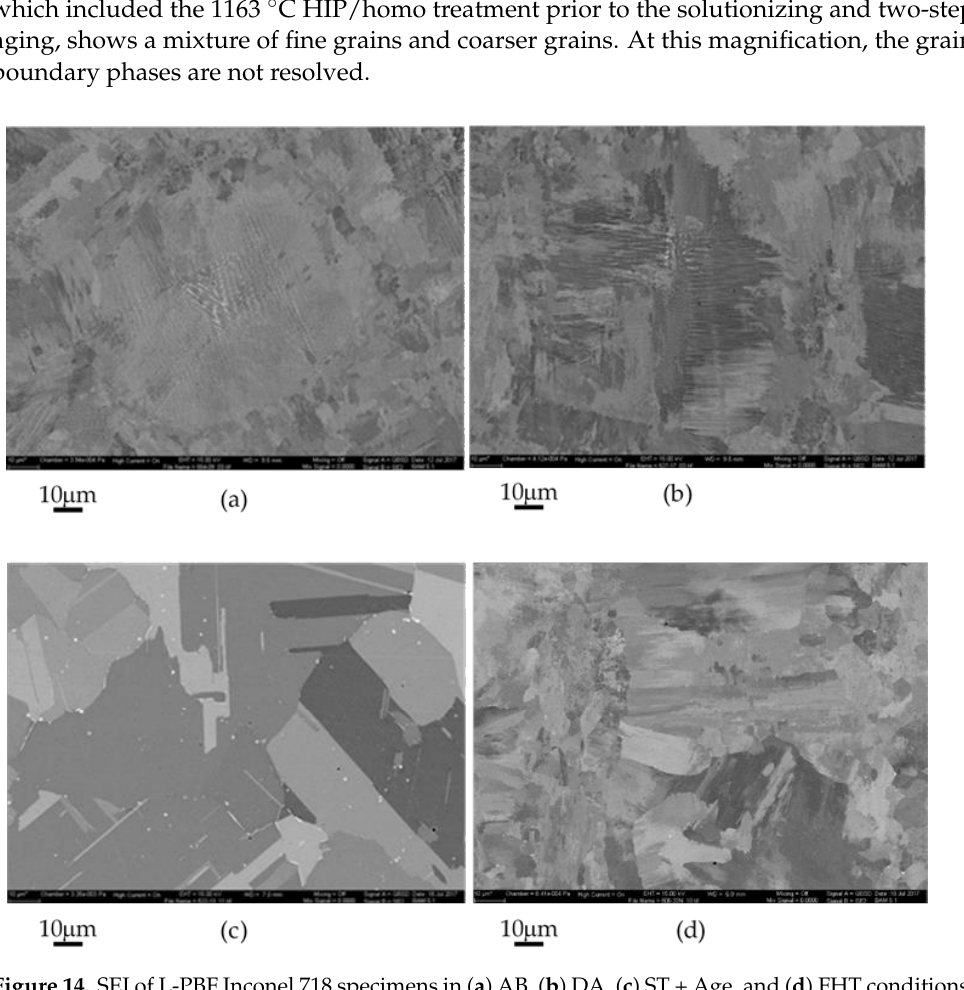
Figure 14. SEI of L-PBF Inconel 718 specimens in ( a ) AB, ( b ) DA, ( c ) ST + Age, and ( d ) FHT condi-